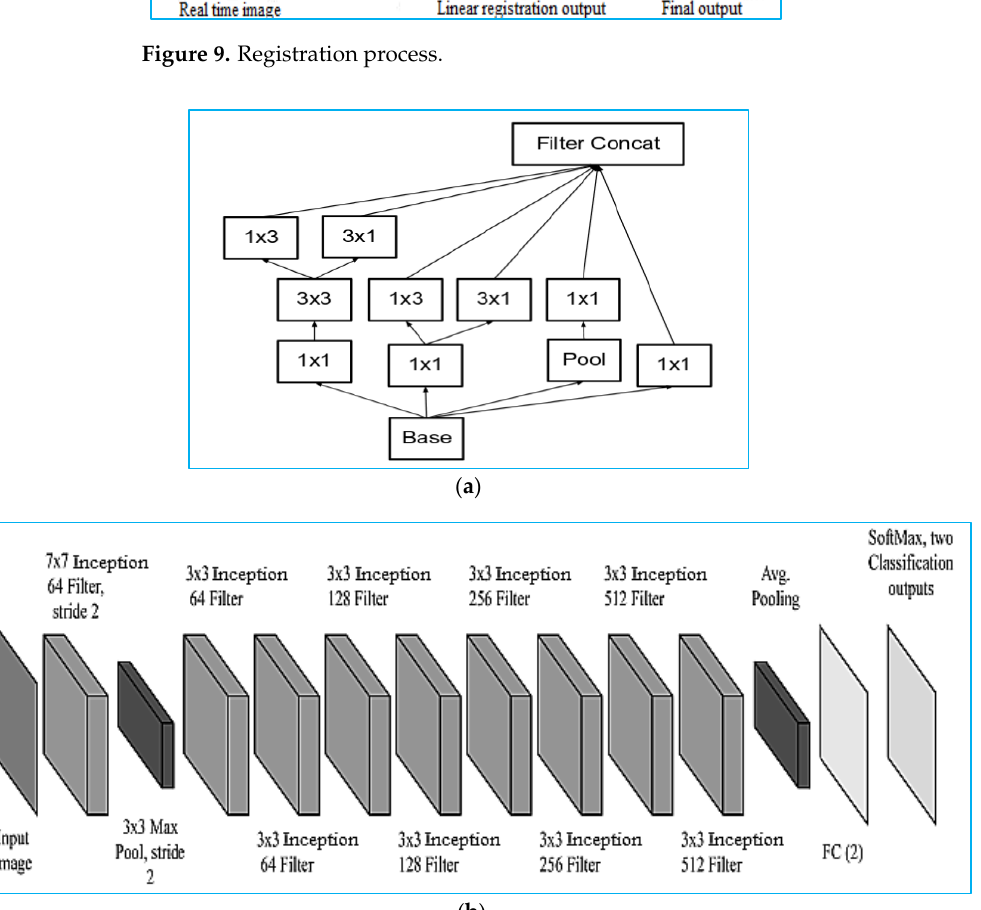
Figure 10. ( a ) Proposed GoogLeNet injected ResNet18 model for high accuracy classification. ( b ) Architecture of the inception module injected in ResNet18.